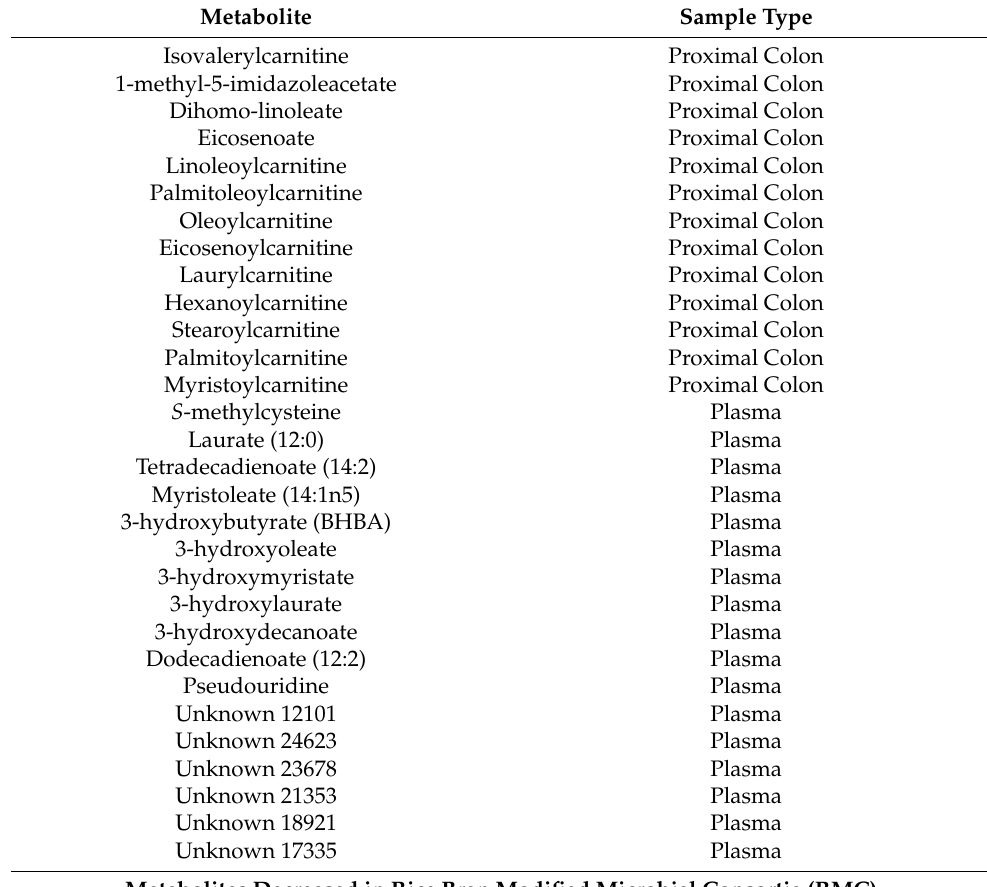
Table 1. Selected blood and intestinal metabolites and microbial taxa with relationships to the cancer protective outcomes following fecal microbiota transplantation (FMT) with rice bran modified microbiota (RMC) in AOM-DSS treated